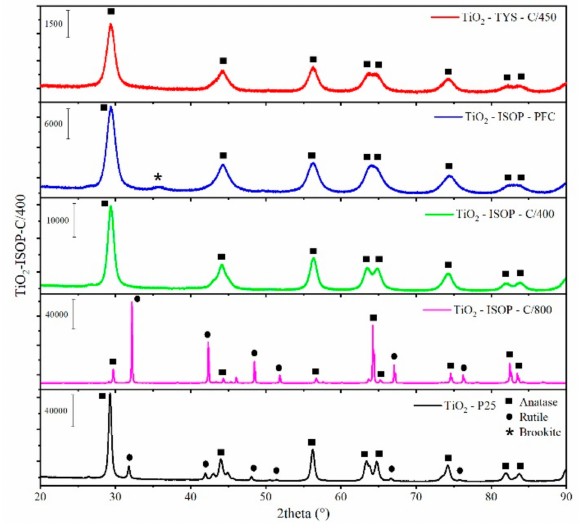
Figure 2. XRD patterns of investigated TiO 2